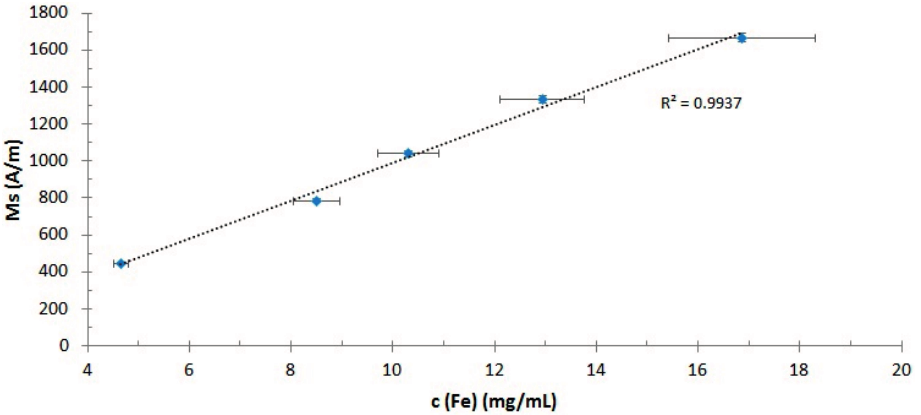
Figure 5. Increase of the saturation magnetization of SEON LA-BSA of the